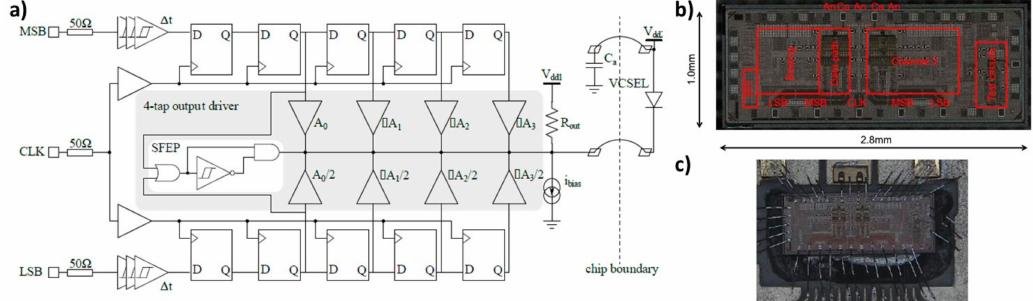
Figure 2. ( a ) Single-channel block diagram of a PAM-4 VCSEL driver, ( b ) annotated die photo of the VCSEL driver, ( c ) VCSEL driver board closeup.